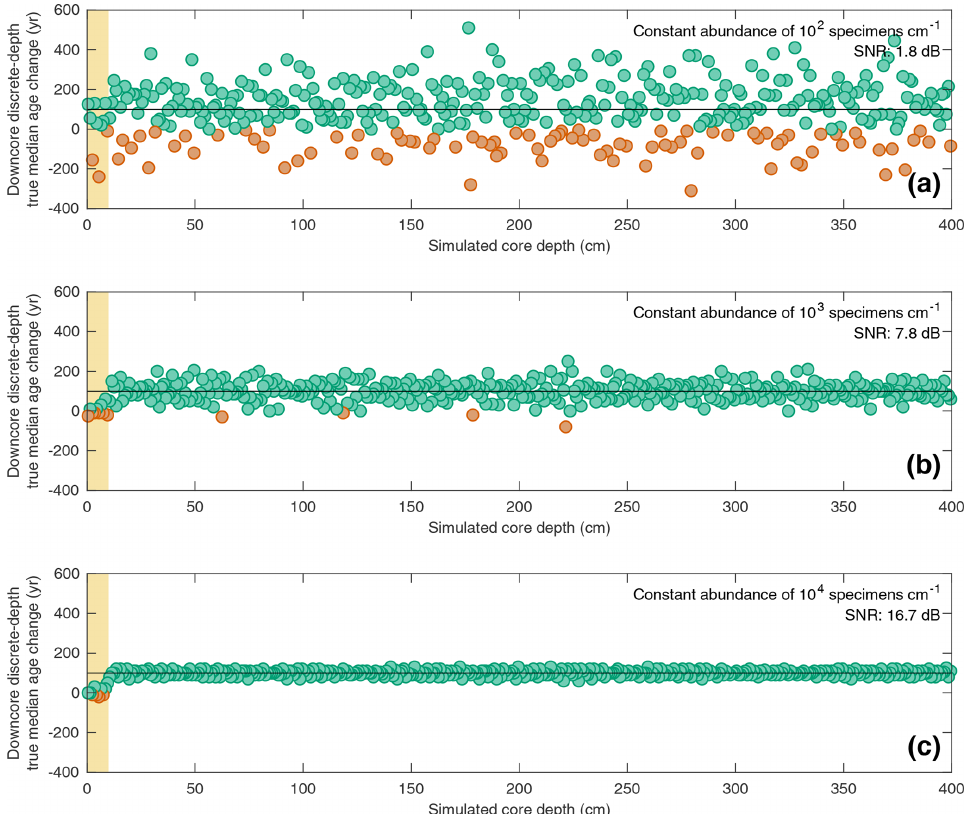
Figure 5. Estimating downcore age–depth noise induced by absolute species abundance in three scenarios all involving a constant SAR of 10cmkyr − 1 and constant bioturbation depth of 10cm. In all three panels, the data points (circles) indicate the downcore discrete-depth median age increase for each centimetre of core depth. Green circles correspond to positive downcore median age change, while orange data points correspond to negative downcore median age change (i.e. apparent age reversals). The horizontal black line in each panel denotes the perfect downcore age change of + 100yrcm − 1 that would be associated with a constant SAR of 10cmkyr − 1 . The yellow interval denotes the still-active BD (10cm) at the core top. The signal-to-noise ratio (SNR) is also computed for each scenario as the ratio between the summed squared magnitudes of the signal and of the noise. The still-active BD at the core top is excluded from the SNR calculation. Three different abundance scenarios are shown: (a) constant abundance of 10 2 specimenscm − 1 ; (b) constant abundance of 10 3 specimenscm − 1 ; (c) constant abundance of 10 4 specimenscm − 1